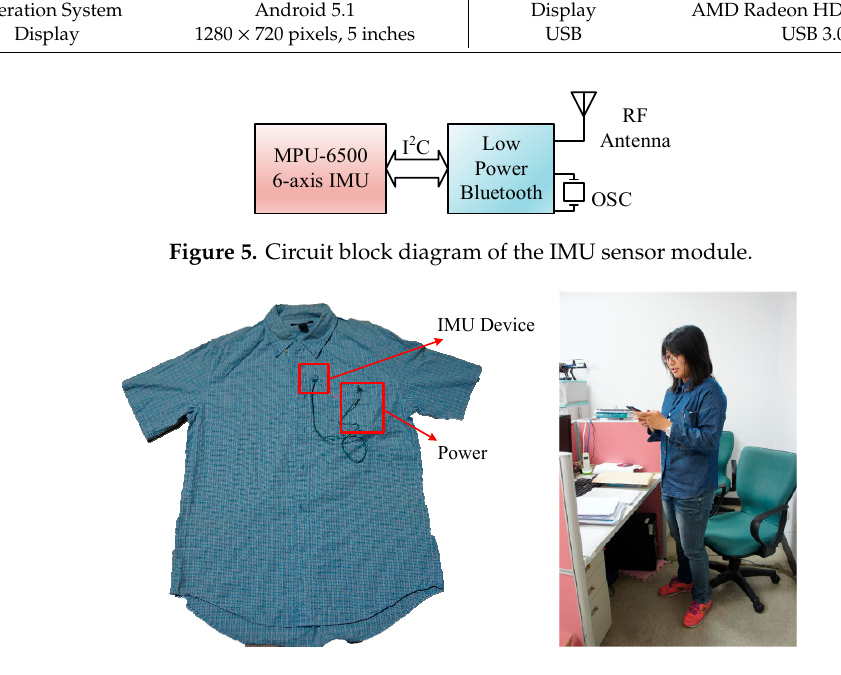
Figure 6. Installation of the IMU device.